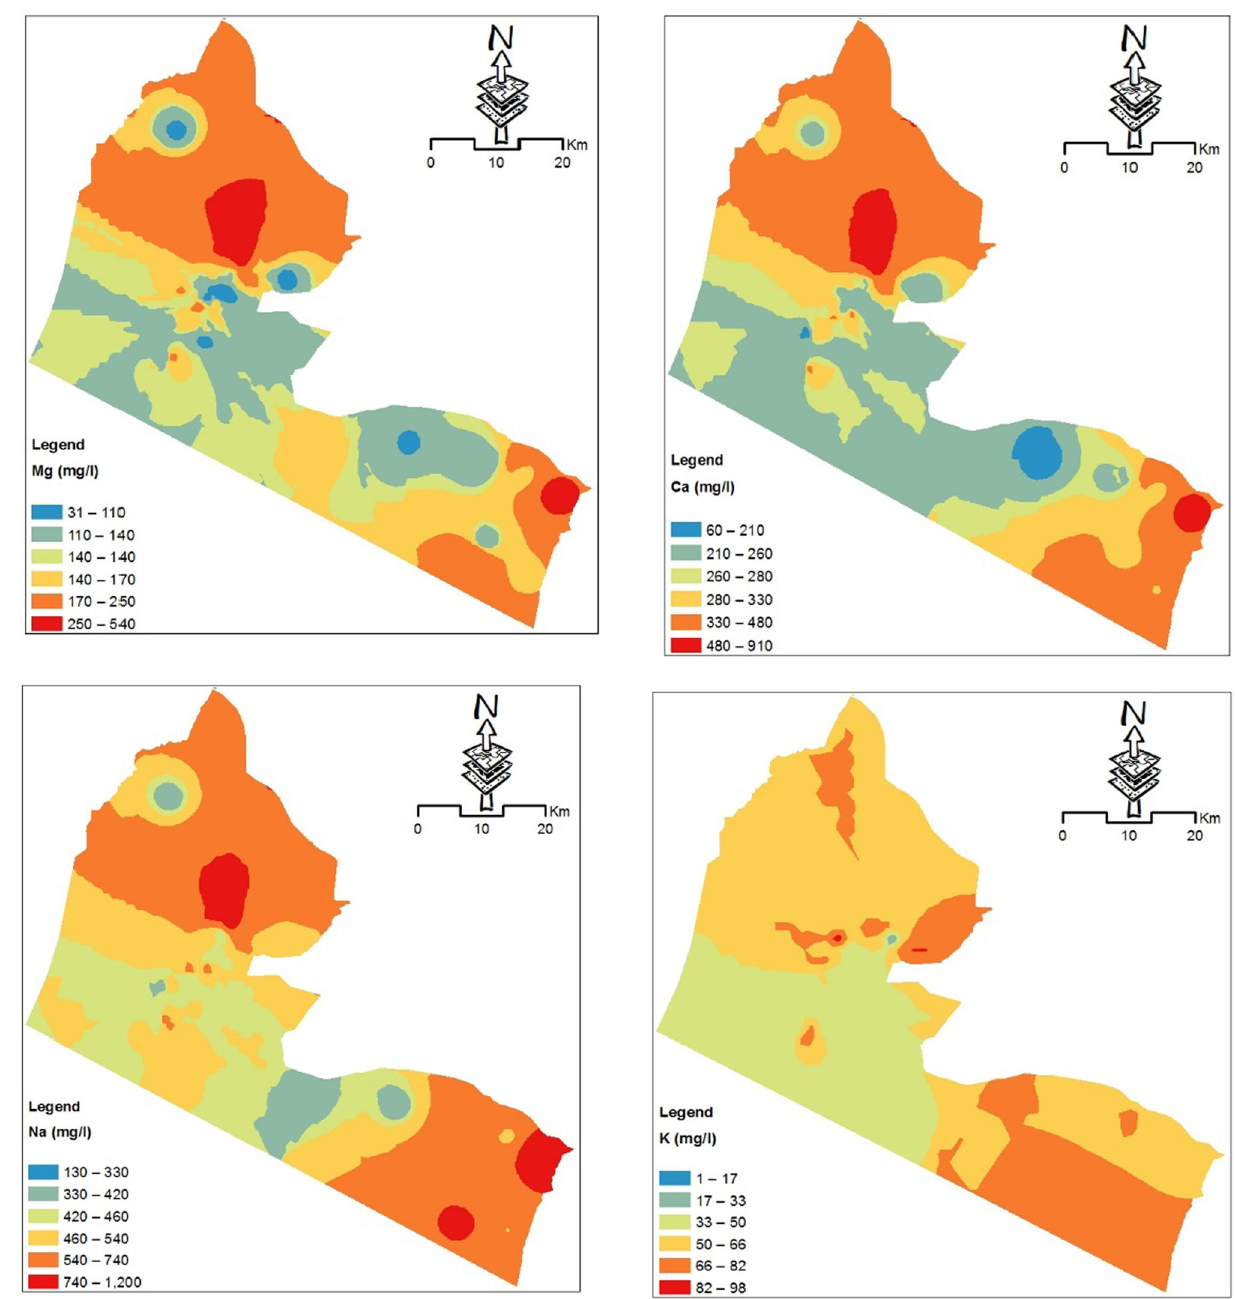
Fig. 6 Spatial distribution pattern of cations (Ca 2 ? , Mg 2 ? , Na ? and K ? )